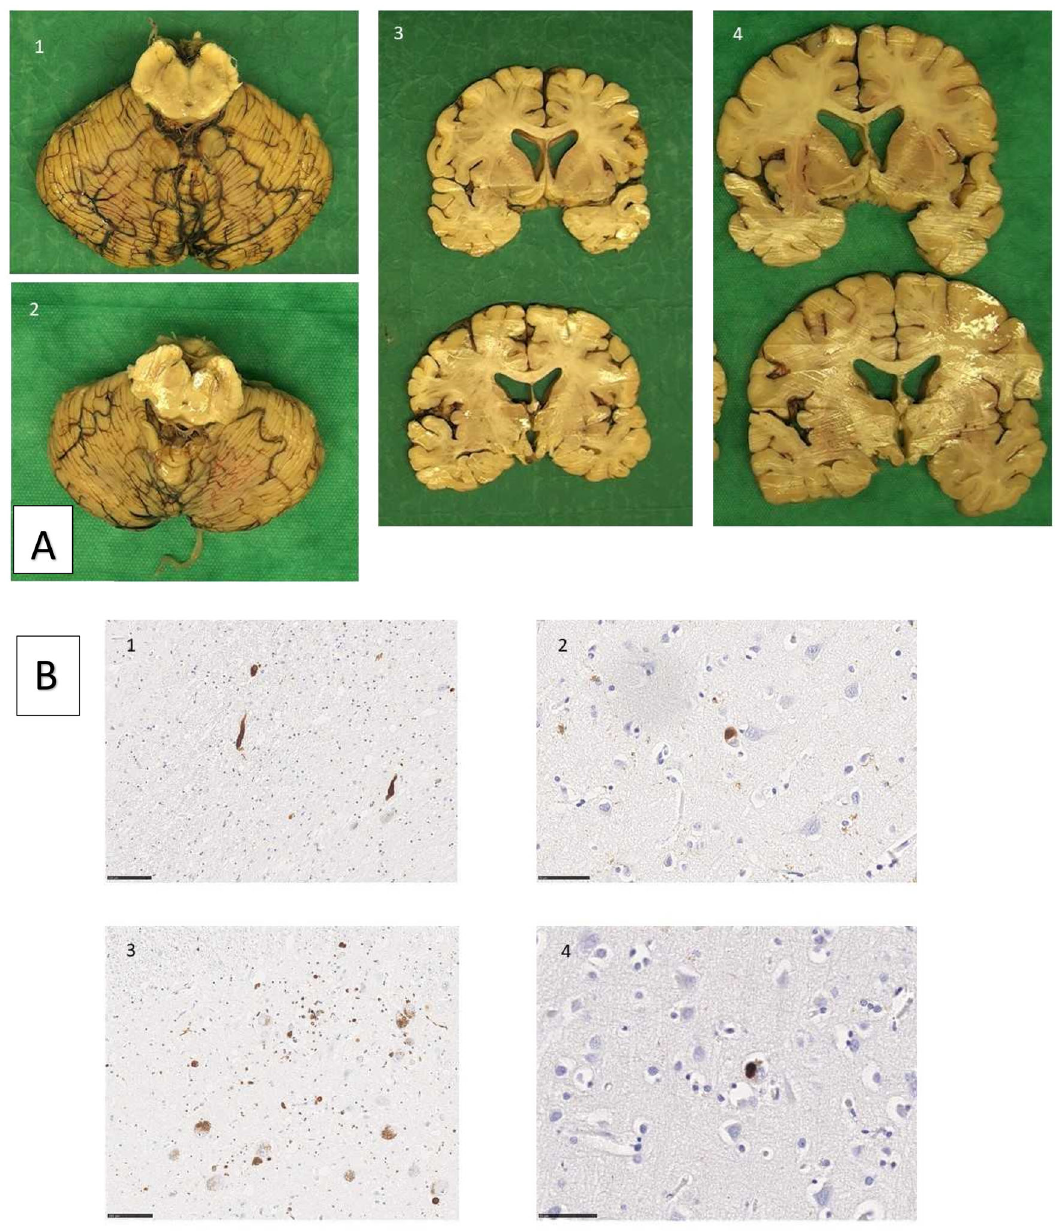
Fig. 2 Neuropathological images. A Macroscopic images. 1. Substantia nigra and cerebellum (proband). 2. Substantia nigra and cerebellum (sister). 3. Coronal sections including basal ganglia (proband). 4. Coronal section including basal ganglia (sister). B Microscopic images. 1. Lewy neurites (substantia nigra, proband). 2. Cortical lew body (proband). 3. Lewy bodies and neurites (substantia nigra, sister). 4. Cortical Lewy body,